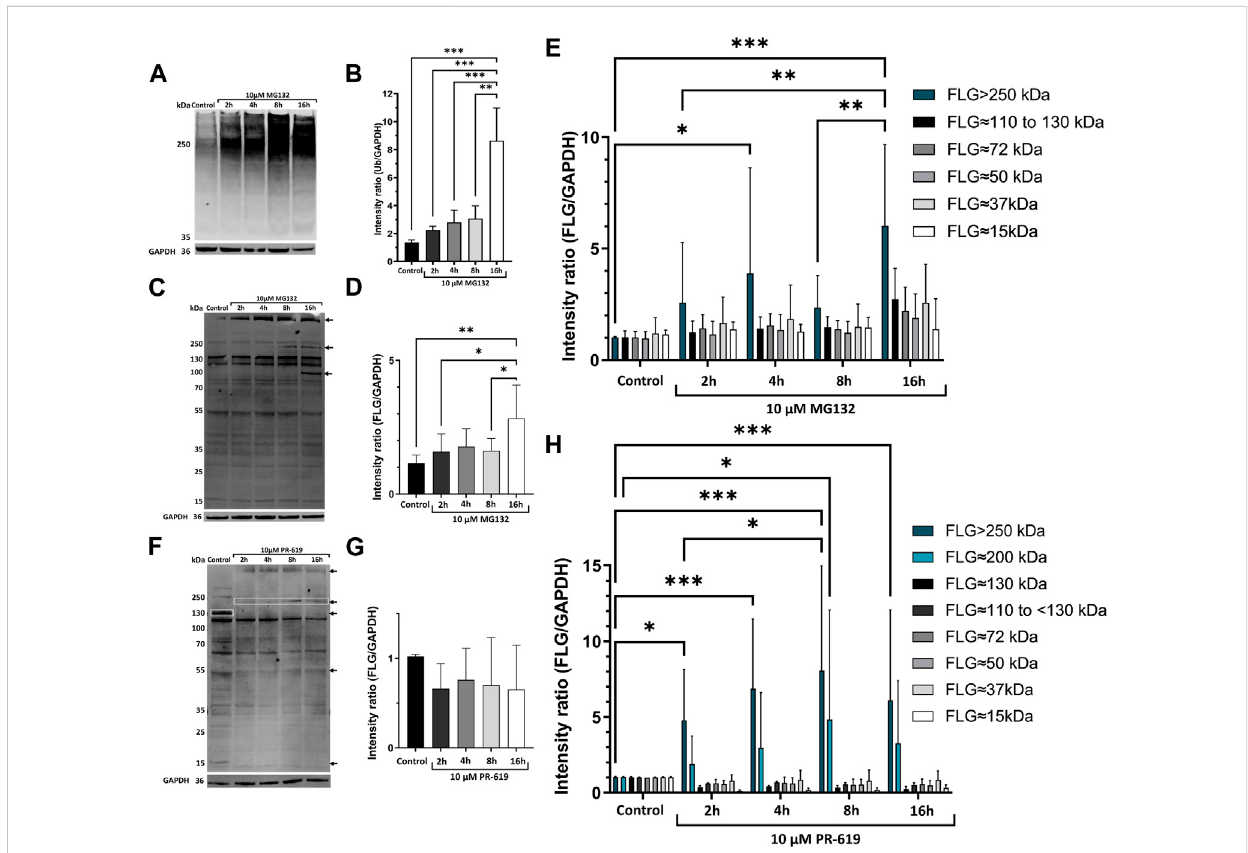
FIGURE 1 UPS is involved in degradation of pro fi laggrin. (A) Western blot with anti-ubiquitin in the keratinocytes upon treatment with proteasome inhibitor MG132; (B) Intensity ratio of ubiquitinated protein bands after proteasome inhibition for 2 h, 4 h, 8 h and 16 h; one-way ANOVA followed with Tukey ’ s multiple comparison test. (C) Western blot with anti- fi laggrin in keratinocytes upon 2 h, 4 h, 8 h and 16 h treatment of proteasome inhibitor MG132, arrows indicate accumulation of undegraded pro fi laggrin in proteasome inhibition sample. (D) Intensity ratio of all fi laggrin bands detected in different timepoint treatment of proteasome inhibitor MG132; one-way ANOVA followed by Tukey ’ s multiple comparison test; (E) Intensity ratio of different FLG bands upon MG132 treatment; two-way ANOVA followed by Š idák ’ s multiple comparison test; (F) Western blot with anti- fi laggrin in keratinocytes upon 2 h, 4 h, 8 h and 16 h treatment of deubiquitinase inhibitor PR-619, Top two arrows and top box indicates accumulation of higher molecular weight fi laggrin bands in the deubiquitinase inhibited samples whereas, deubiquitinase inhibition leads to depletion or disappearance of fi laggrin bands of approximately 130, 50 and 15 kDa pointed with bottom box and arrows. (G) Intensity ratio of all fi laggrin bands detected in different timepoint treatment of deubiquitinase inhibitor PR-619; one-way ANOVA followed by Tukey ’ s multiple comparison test; (H) Intensity ratio of different FLG bands upon PR-619 treatment; two-way ANOVA followed by Š idák ’ s multiple comparison test; error bar stands for + SD and p -value < 0.001(***); p -value ≤ 0.002(**); p -value ≤ 0.033(*); ( n =